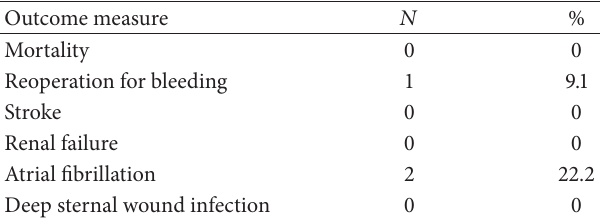
Table 2: Postoperative